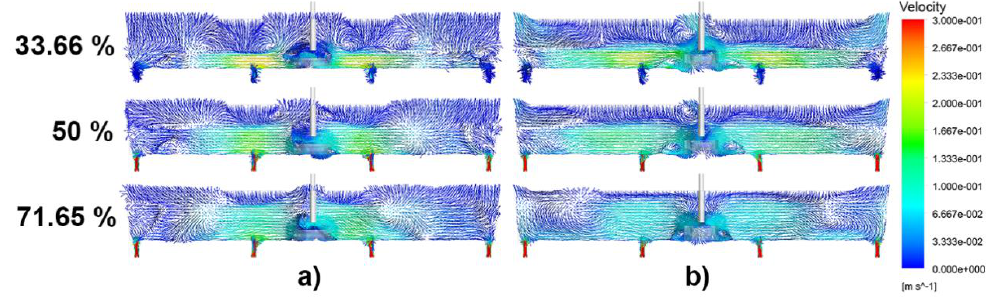
Figure 8. Velocity fields in planes passing through the positions of the four strands at different height percentages of the operating level in the tundish: ( a ) TI1; ( b ) TI3.